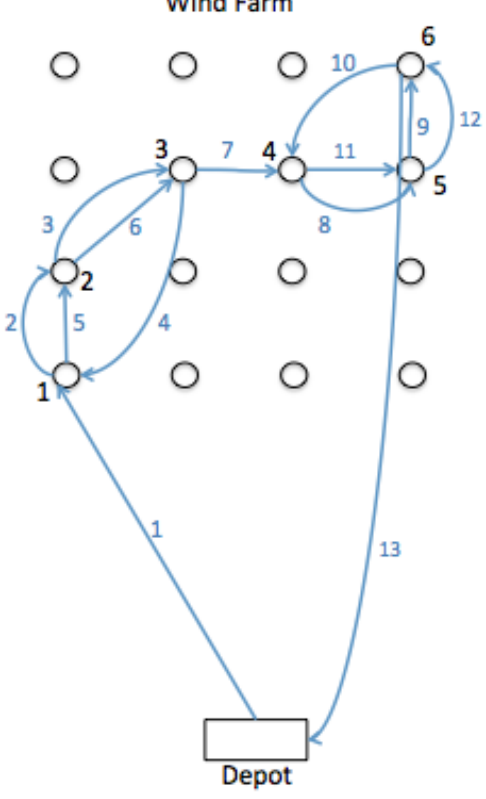
Figure 1. Example of a route for a vessel that performs tasks in parallel. The vessel delivers technicians to turbine 1, 2 and 3 and waits until the tasks are performed. The vessel then picks up the technicians and delivers them to turbine 4, 5 and 6. The arc numbers correspond to the order the distances are